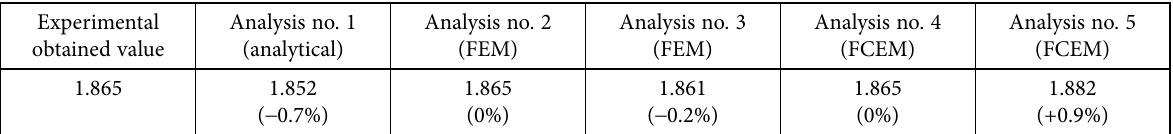
Table 1. Static δ (mm) results due to a concentrated force of 1 kN, obtained with different methods for the studied concrete max beam problem, and the corresponding error percentage to the obtained experimental value Experimental Analysis no. 1 obtained value